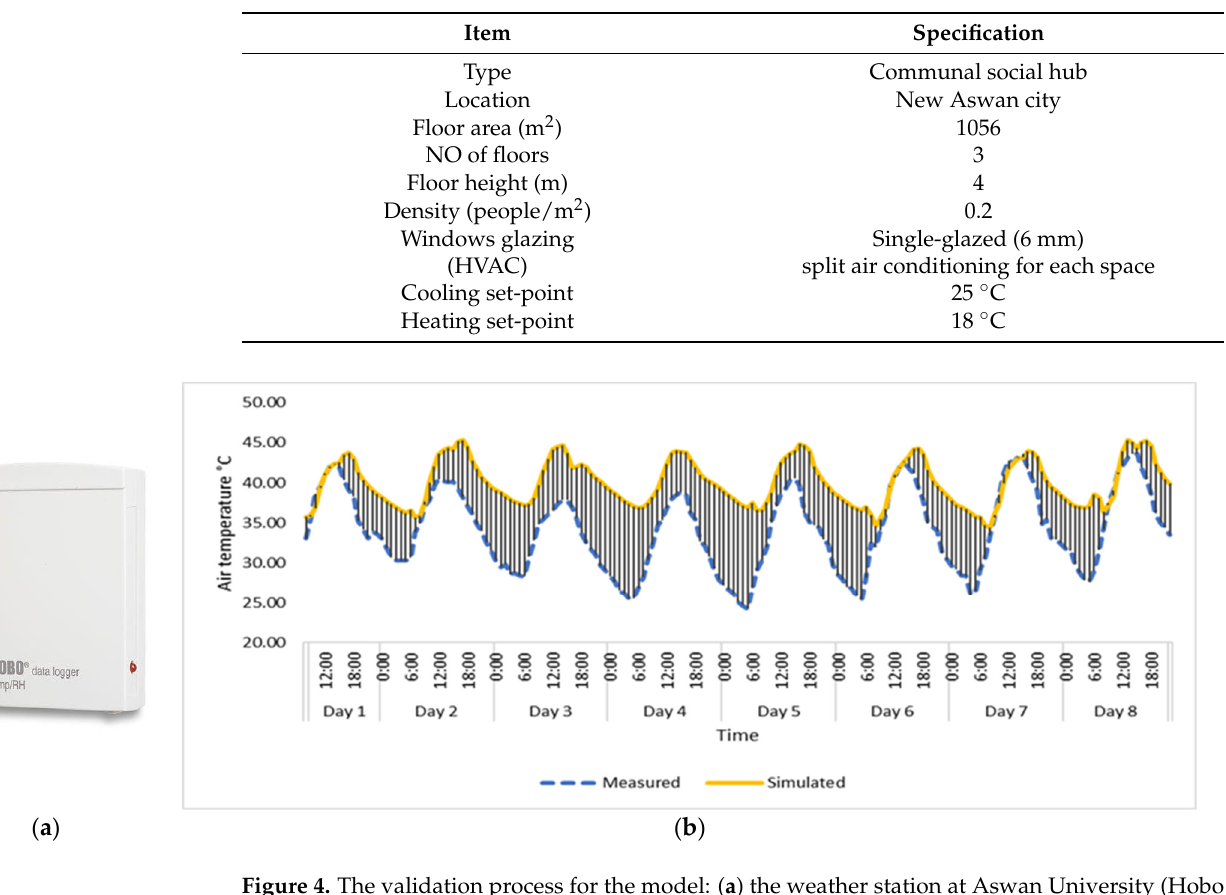
Table 1. The simulation input data and assumptions of the study model.